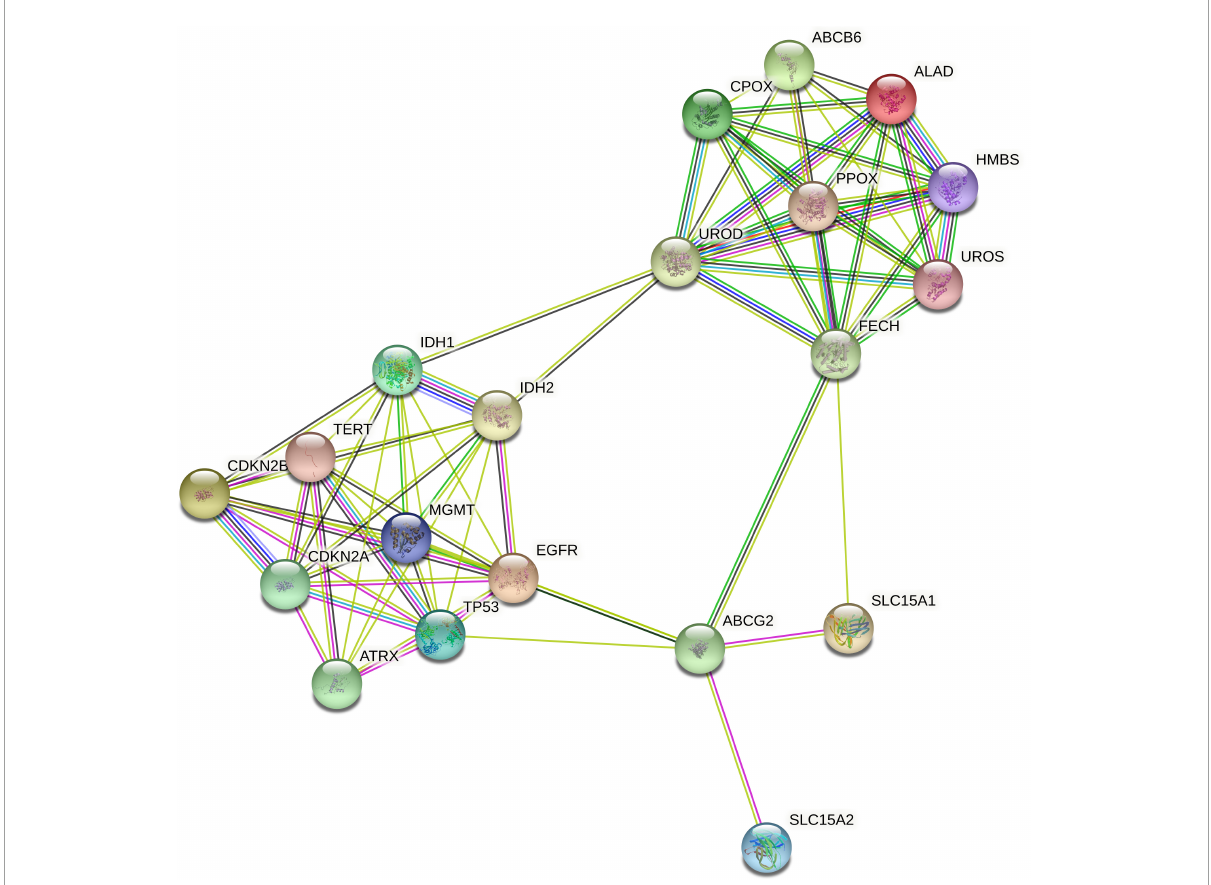
FIGURE5 STRING protein interaction analysis of heme biosynthesis and glioma markers. STRING database analysis of metabolic interactions between heme biosynthesis factors and molecular glioma markers demonstrated that both subgroups of proteins form tightly interlinked networks that are nearly completely isolated from each